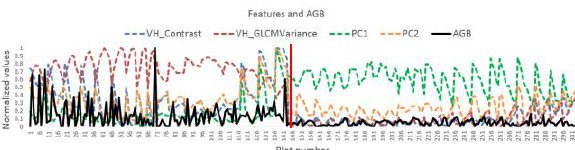
Figure 13. Line graph of selected features and AGB for both